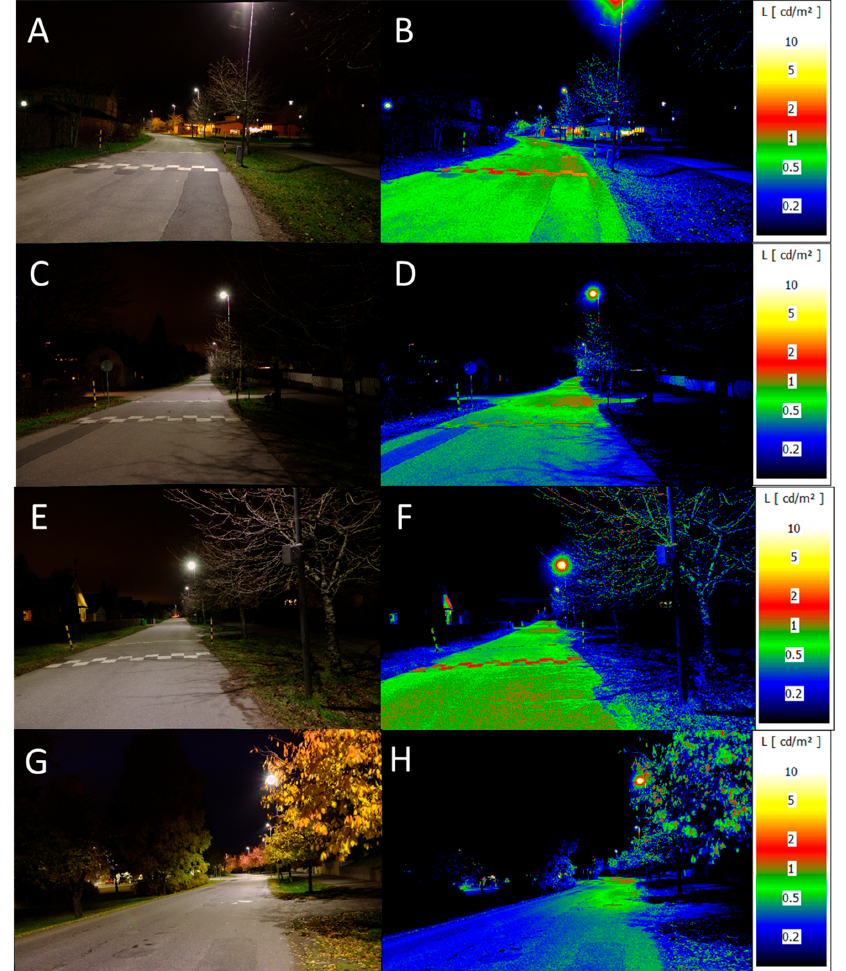
Figure 3. Photos and luminance photos of bumps and control location. Photographs ( A – F ) were taken on 15 November 2014 between 17:00–19:00 and photos ( G – H ) (control location) on 24 October 2015 at 18:30. All of the photos were taken with a Canon EOS 550D (with Sigma lens 18–50 mm, F2,8 , iso 100) 150 cm above the ground on a tripod.